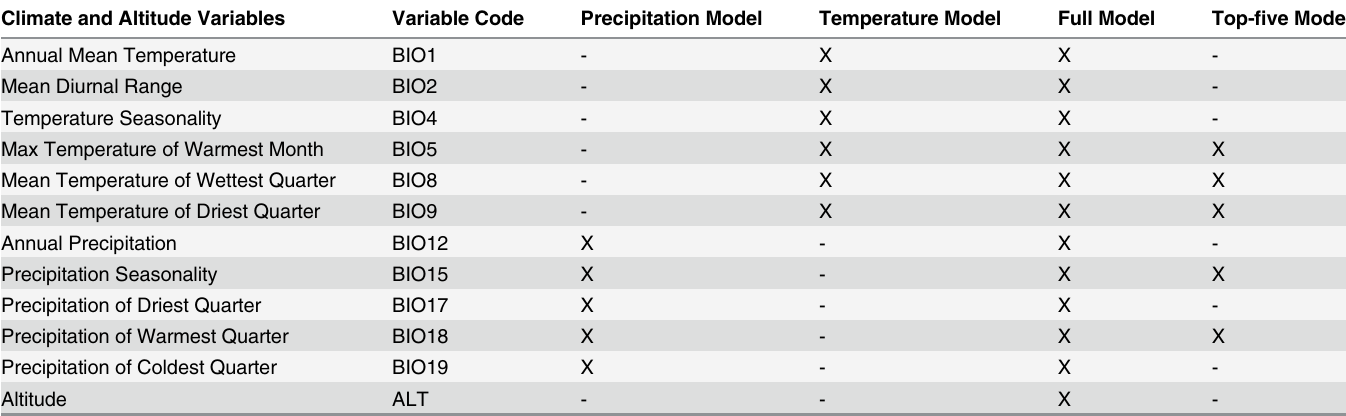
Table 1. Climate and altitude variables for the four species distribution models of O . turicata constructed using